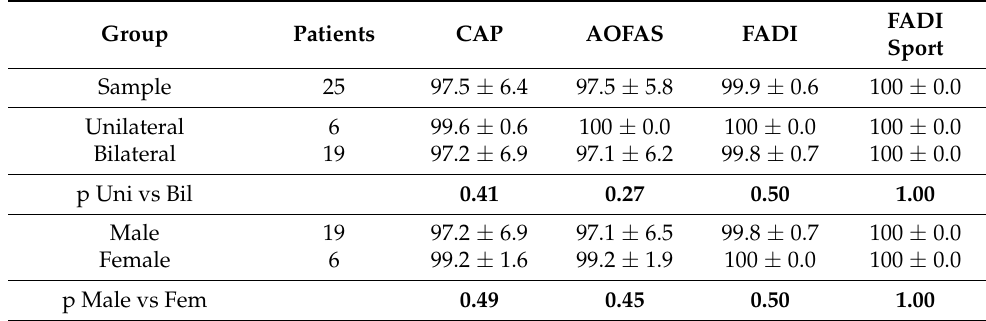
Table 2. Clinical assessment. Results reported in mean and standard deviation. Group Patients CAP